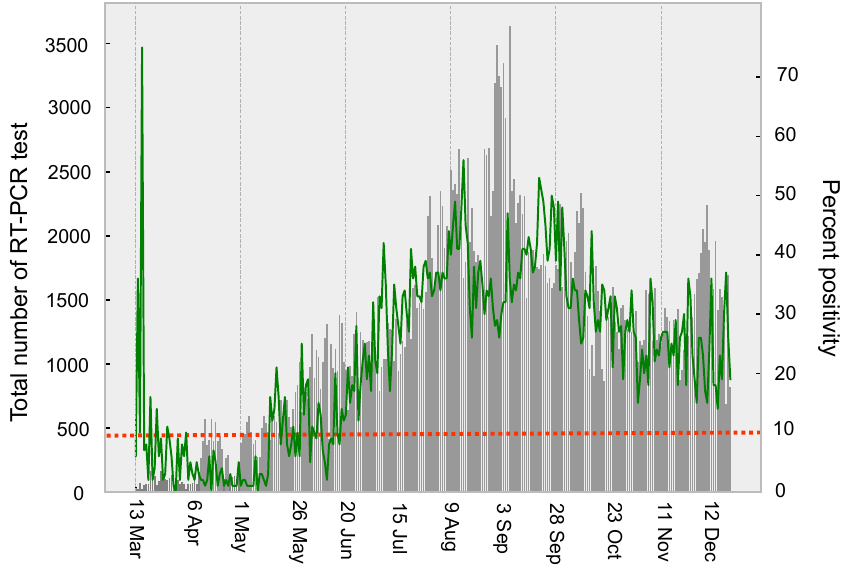
Figure A2. RT-PCR testing in Venezuela. The grey bars indicate the total number of tests carried out and the green line estimates the percent positivity. The red dotted line corresponds to the positivity recommended by the WHO for an adequate case